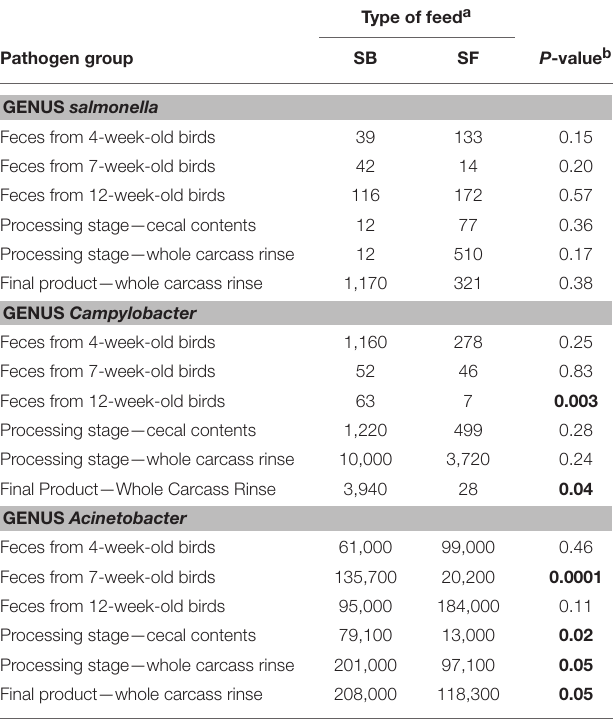
TABLE 5 | Effect of diet on relative abundance of selected foodborne pathogen groups (parts-per million).